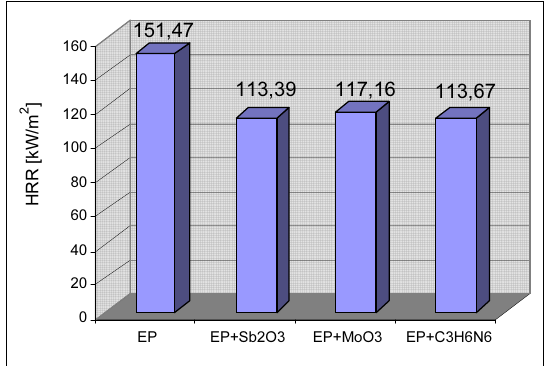
Fig. 3. The average value of heat release rate of unmodi- fied (EP) and modified epoxy material at external flux of